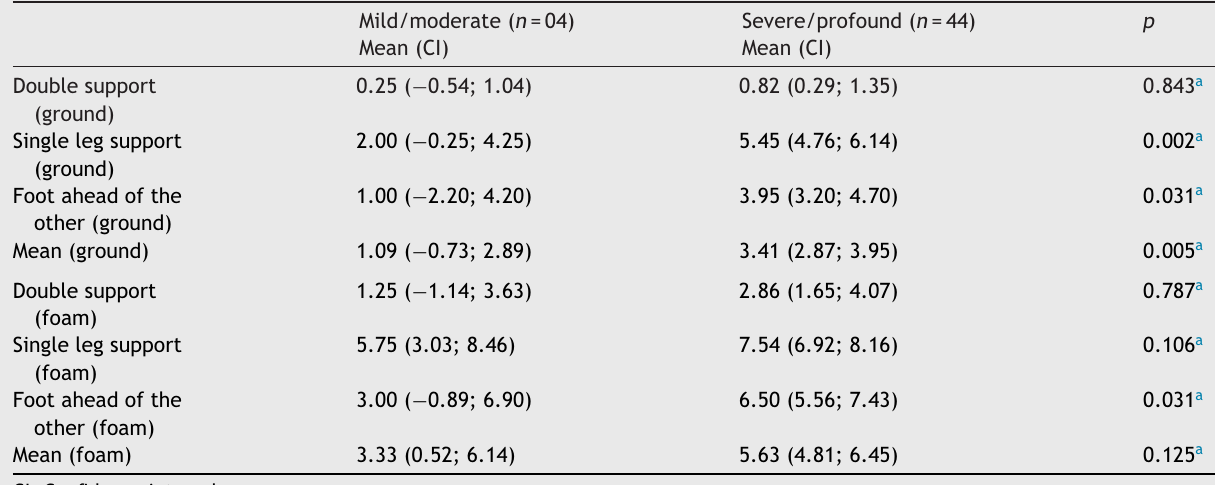
Table 6 Mean and confidence interval values for performance of postural control of students listeners and with sensorineural hearing loss according to degree of hearing loss ( n =